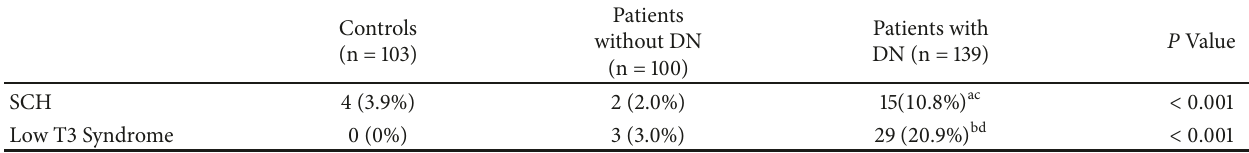
Table 2: Prevalence of SCH and low T3